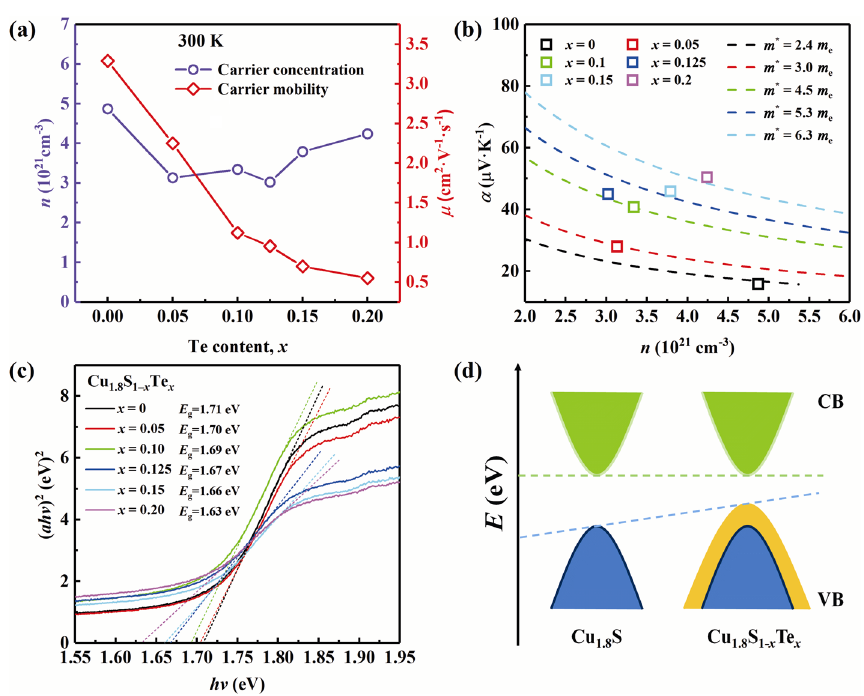
Fig. 4 (a) Variation of n and  as a function of x . (b) Pisarenko plot shows the room-temperature relationship of  and n . (c) Room-temperature optical absorption spectra of Cu 1.8 S 1– x Te x indicate the decreasing E g with increasing x . (d) Schematic representation of the band structure, including conduction band (CB) and valence band